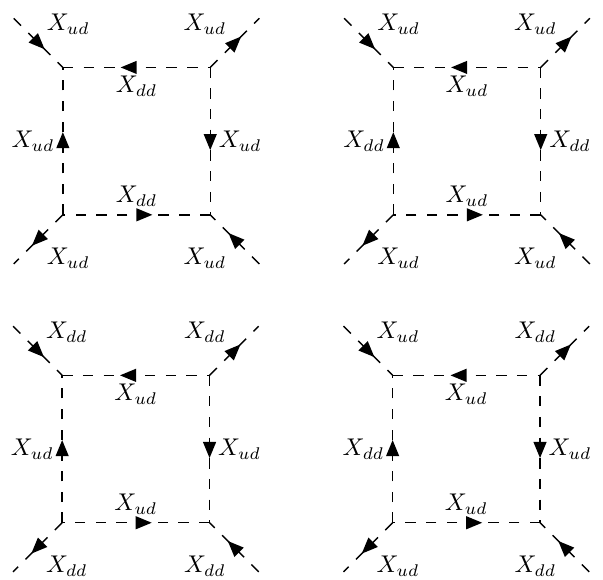
Figure 14 . Diagrams giving rise to the effective quartic interaction terms of the fields X ud and X dd